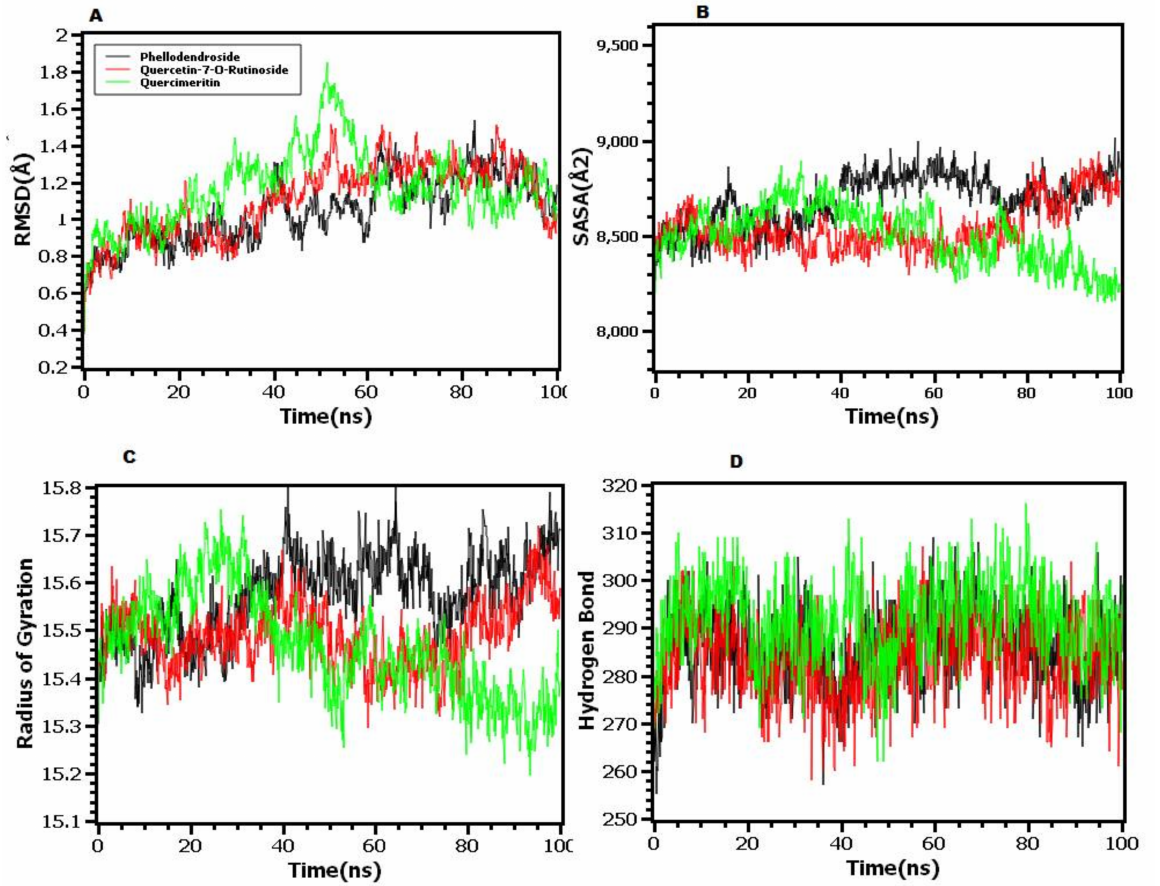
Figure 5. The molecular dynamics simulations study of the docked complexes: ( A ) root mean square deviations, ( B ) solvent accessible surface area, ( C ) radius of gyration, and ( D ) hydrogen